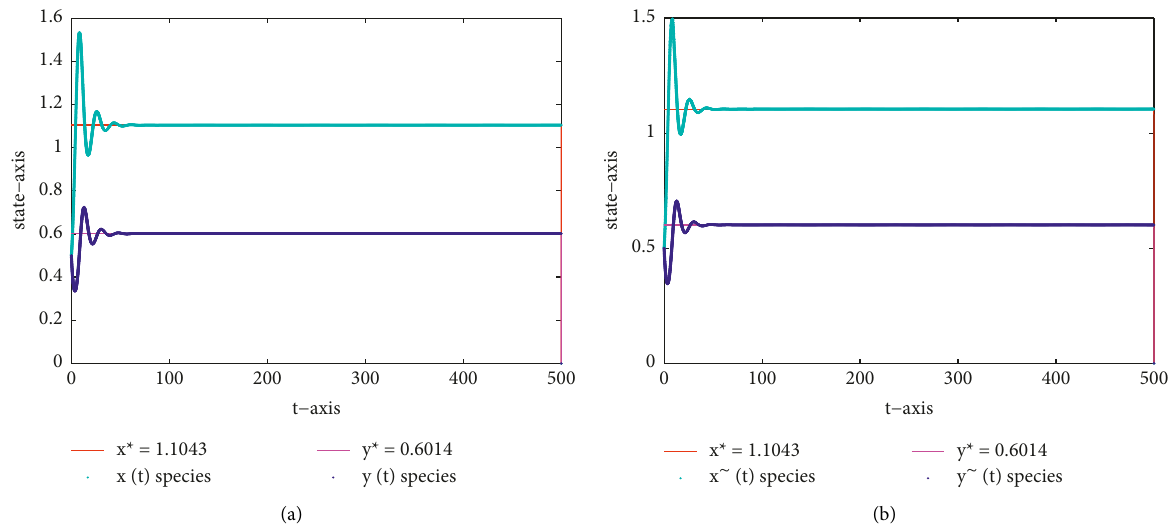
( t ) represent the intensities of prey, y i